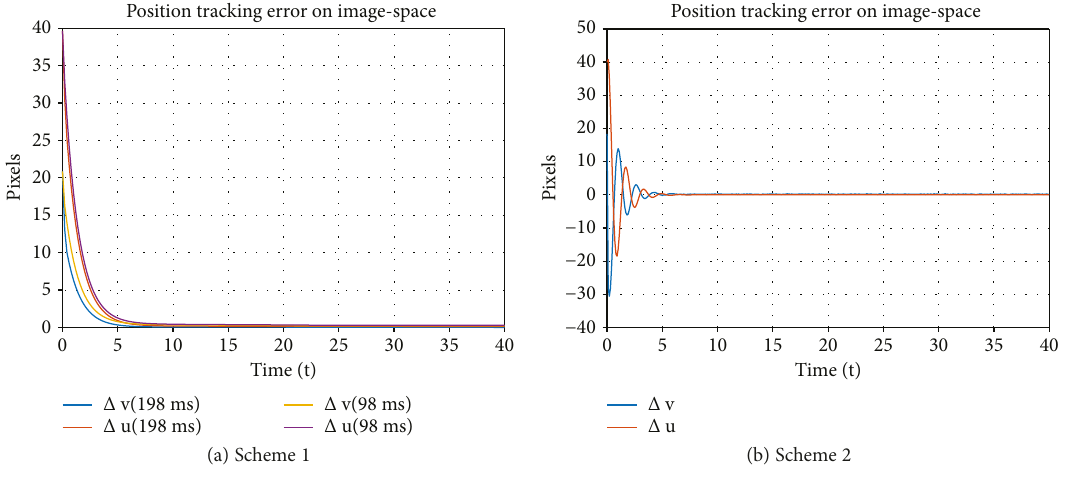
Figure 4: Position tracking errors.